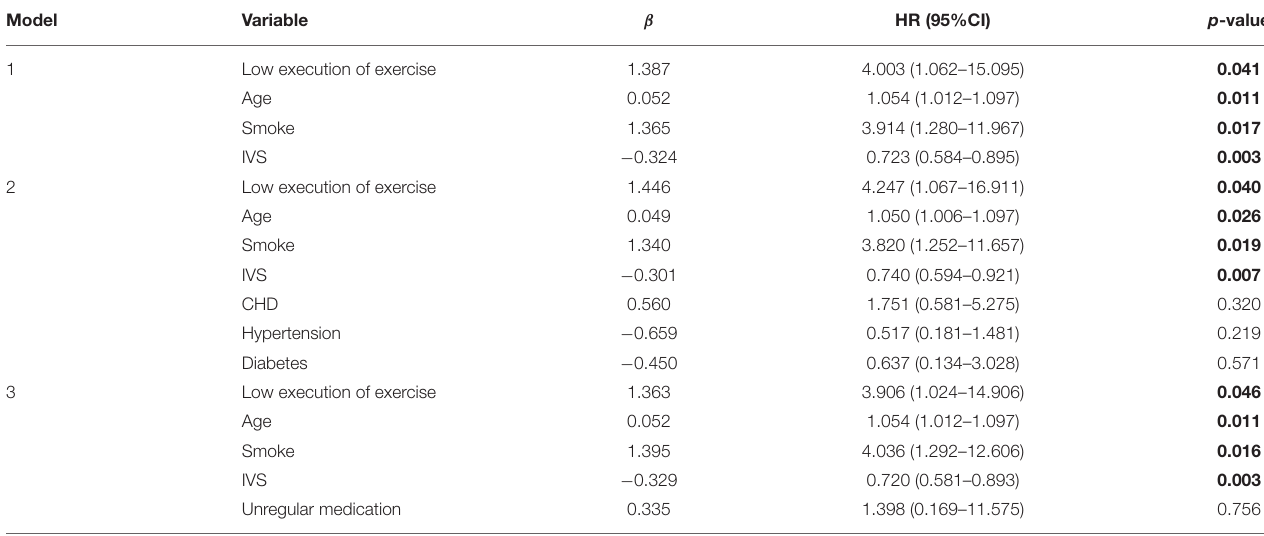
TABLE 5 | Multivariate Cox analysis of proportional risks for CVEs.